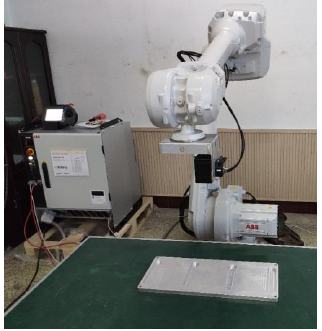
Figure 7. Experimental scene picture.